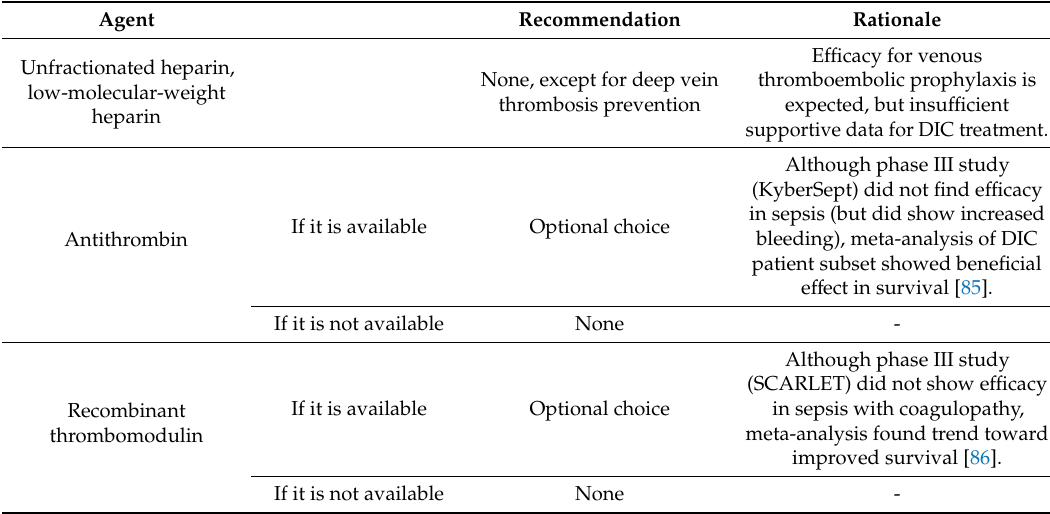
Table 2. Therapeutic agents for DIC /